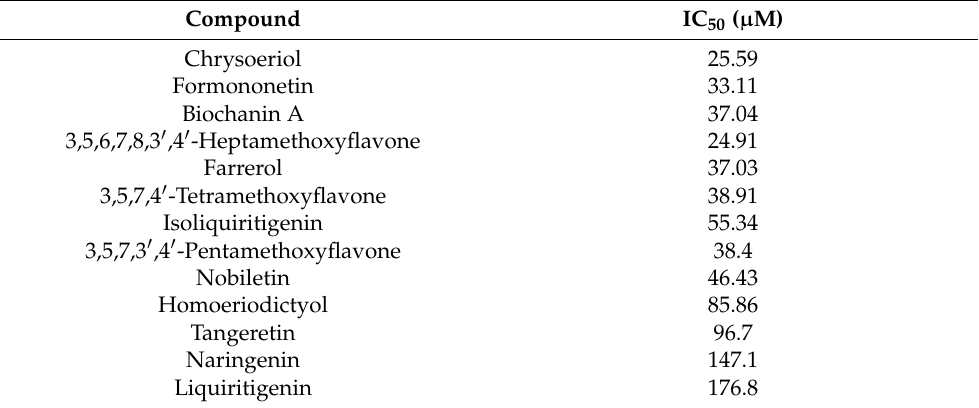
Table 1. Inhibitory activities of flavonoids on PGF2 α -induced uterine contractions of rat ex vivo.